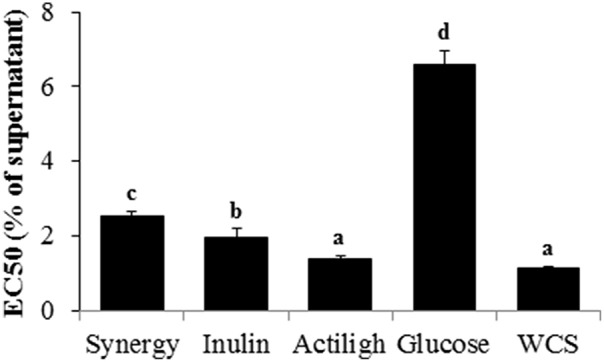
Concentration (% v/v) of supernatants of C. difficile mono-cultures, in the different carbon sources tested, showing 50% of the maximum cell damage (EC50). To calculate EC50s the cell indexes obtained after 12 h of incubation of the HT29 cells with supernatants were used. Different letters above the columns denote statistically significant differences (p < 0.05).